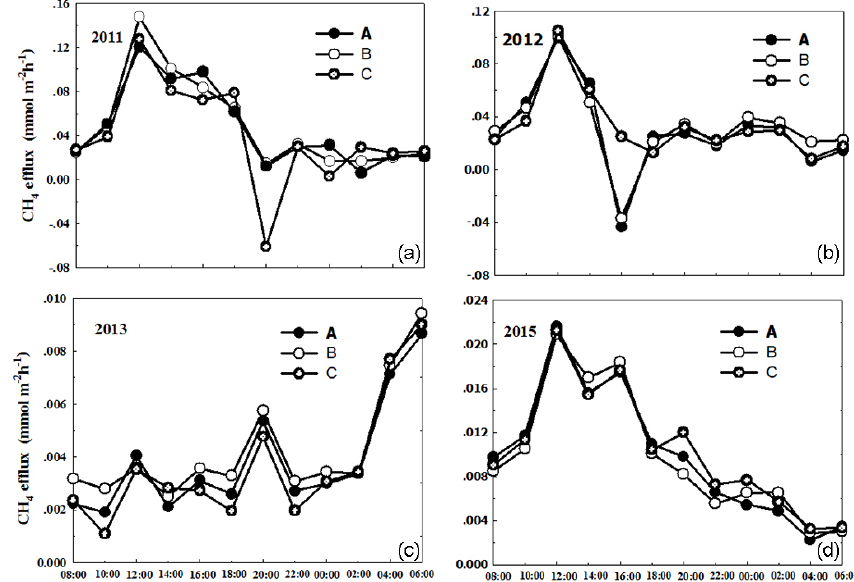
Figure 5. Diel variations of CH 4 effluxes among three sites. Different panels present the diel variations of the CH 4 effluxes on 24– 25 July 2011 (a) , 5–6 September 2012 (b) , 13–14 January 2013 (c) , and 14–15 January 2015 (d)